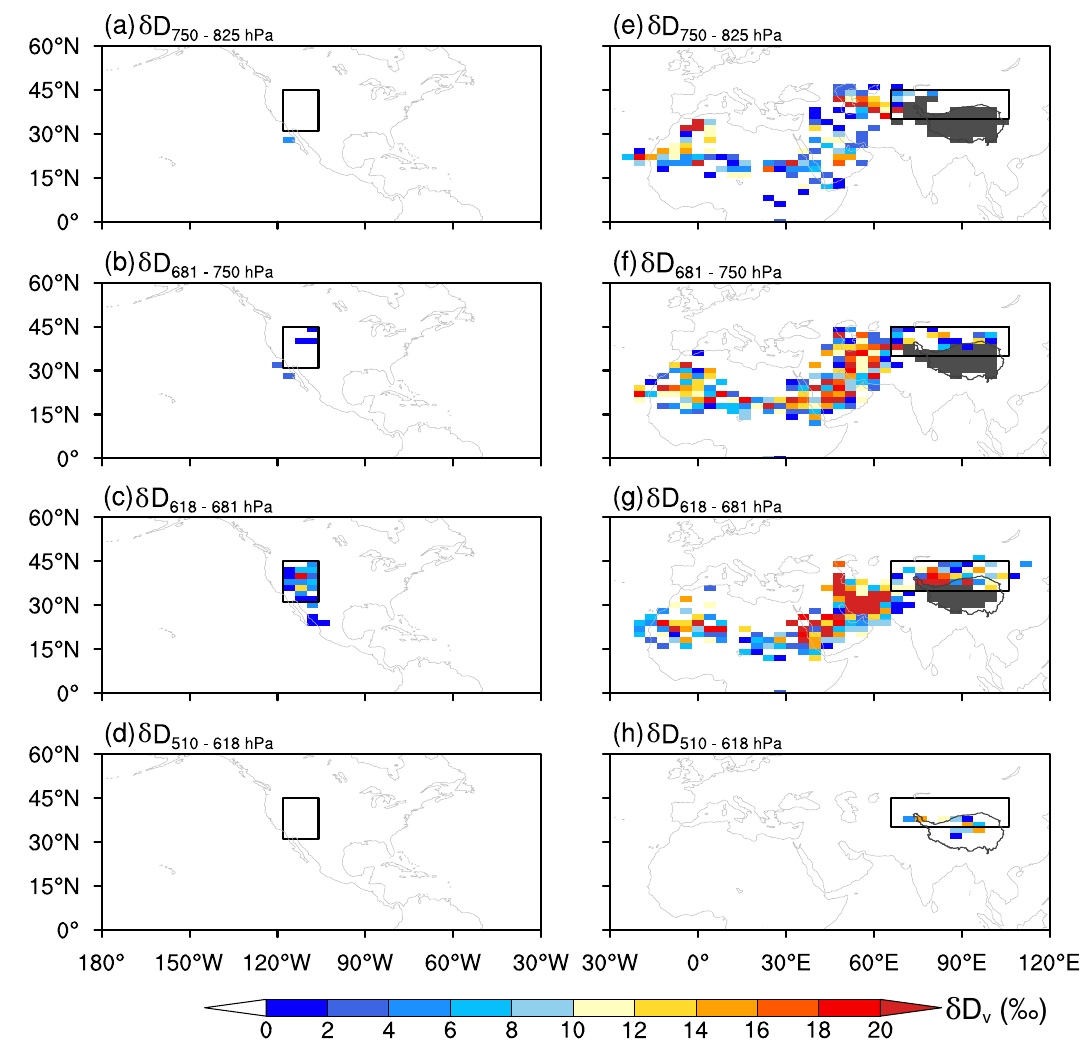
Fig. 2 | Spatial patterns of the IAE at different atmospheric levels in North America and Afro-Eurasia during the summer months. a-d IAE over North America and surroundings. e-h IAE over Afro-Eurasia and surroundings. The δ D v value of the upper level minus the δ D v value of the lower level was taken between the two adjacent atmospheric levels. A positive difference indicates that δ D v increaseswithaltitude,i.e.,theIAEoccurs.Theblackboxesontheleftpanelsshow the WUSA region (31° N – 45° N, 118° W – 106° W) while the black boxes on the right